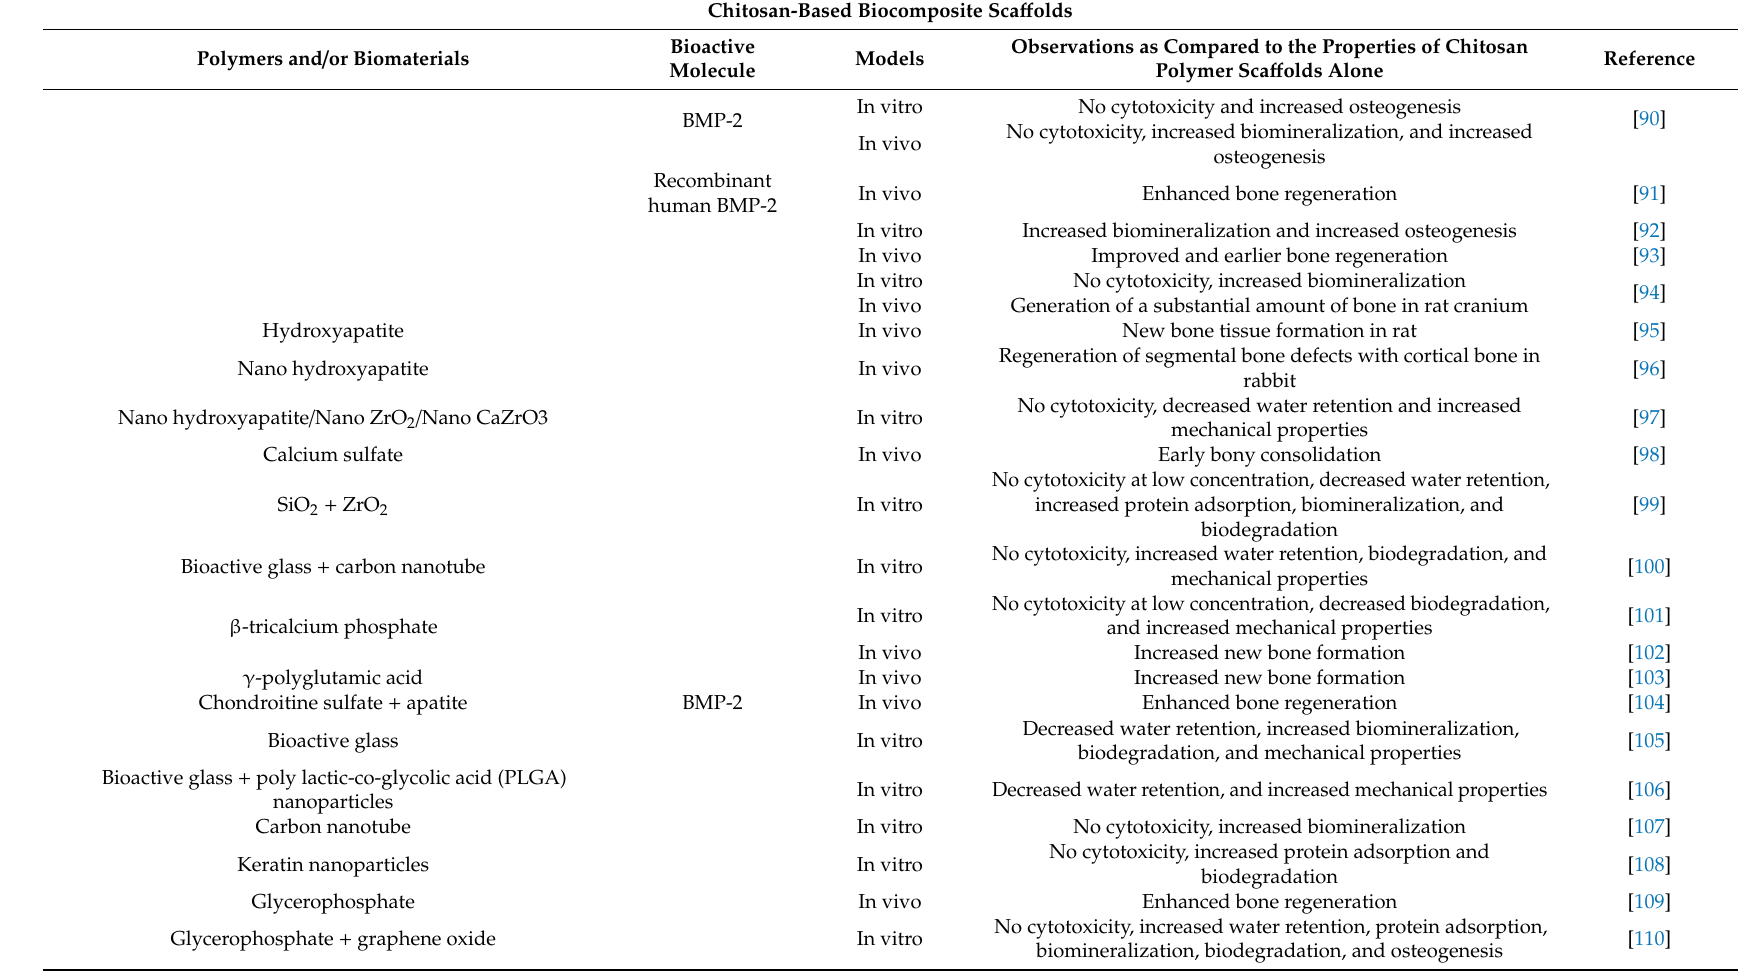
Table 1. In vitro and in vivo studies of chitosan-based biocomposite sca ff olds in bone engineering. VEGF = vascular endothelial growth factor, TGF- β 1 = transforming growth factor beta